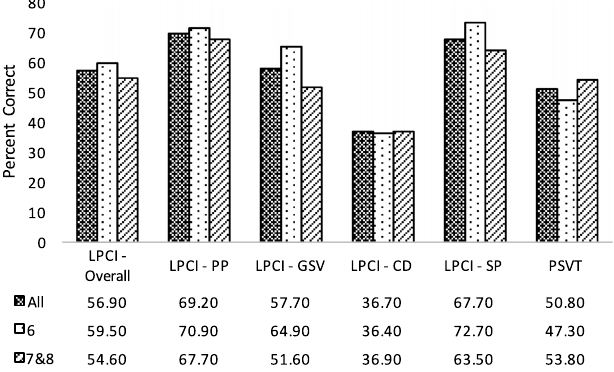
FIG. 2. LPCI (overall and by domain) and PSVT pre-tests percent correct for 6th grade teachers ( n ¼ 11 ) and 7th – 8th ( n ¼ 13 ) grade